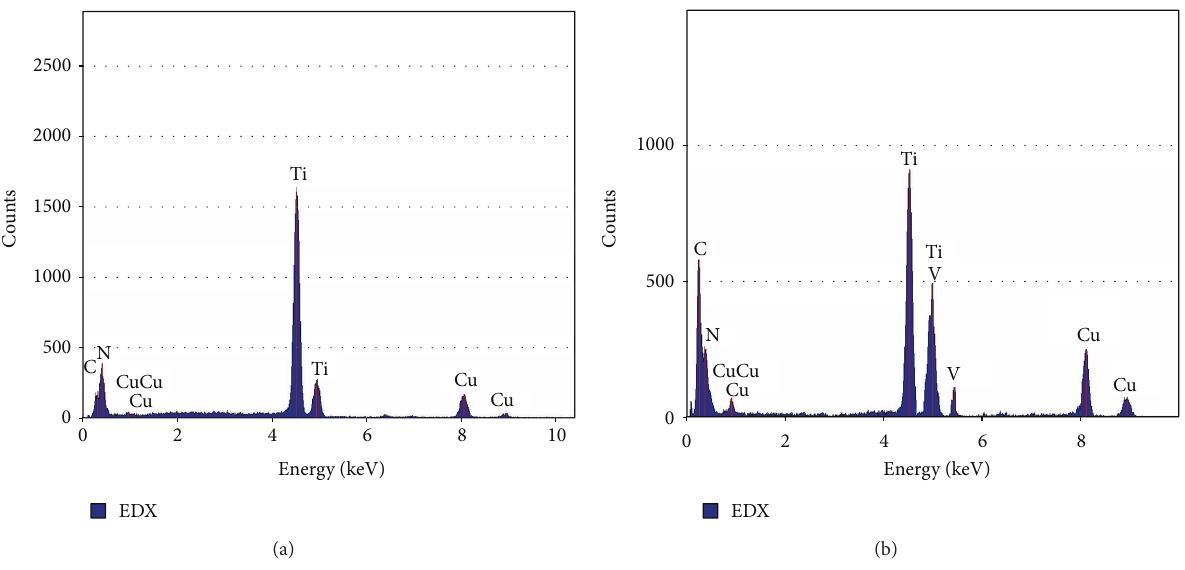
Figure 6: EDS image of the precipitates. (a) 𝜀 = 0.22 , 𝑡 = 10 s; (b) 𝜀 = 0.22 , 𝑡 = 30 s.